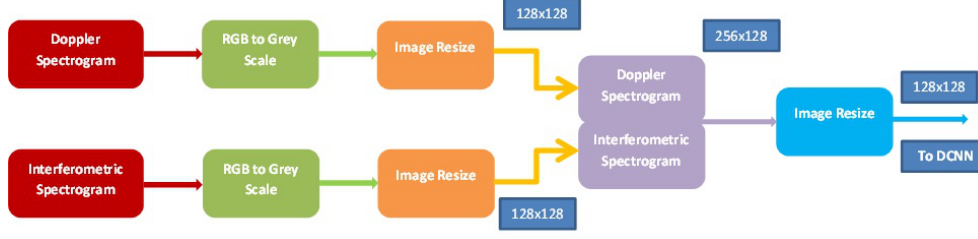
Figure 8. Image pre-processing.